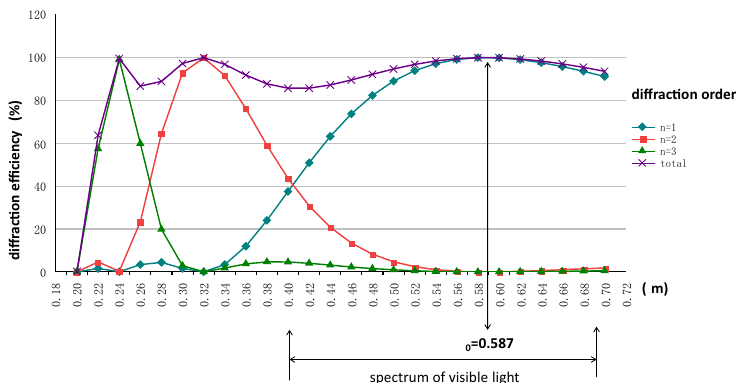
Figure 3. Diffractive efficiency η(λ) of PMMA as a function of the incident light wavelength λ at diffraction order m = 1, 2, and